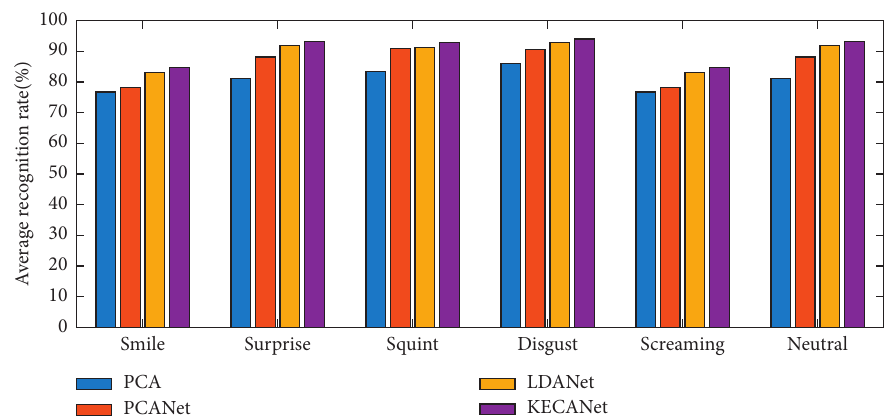
Figure 14: Comparing the test accuracies on the CMU Multi-PIE dataset.